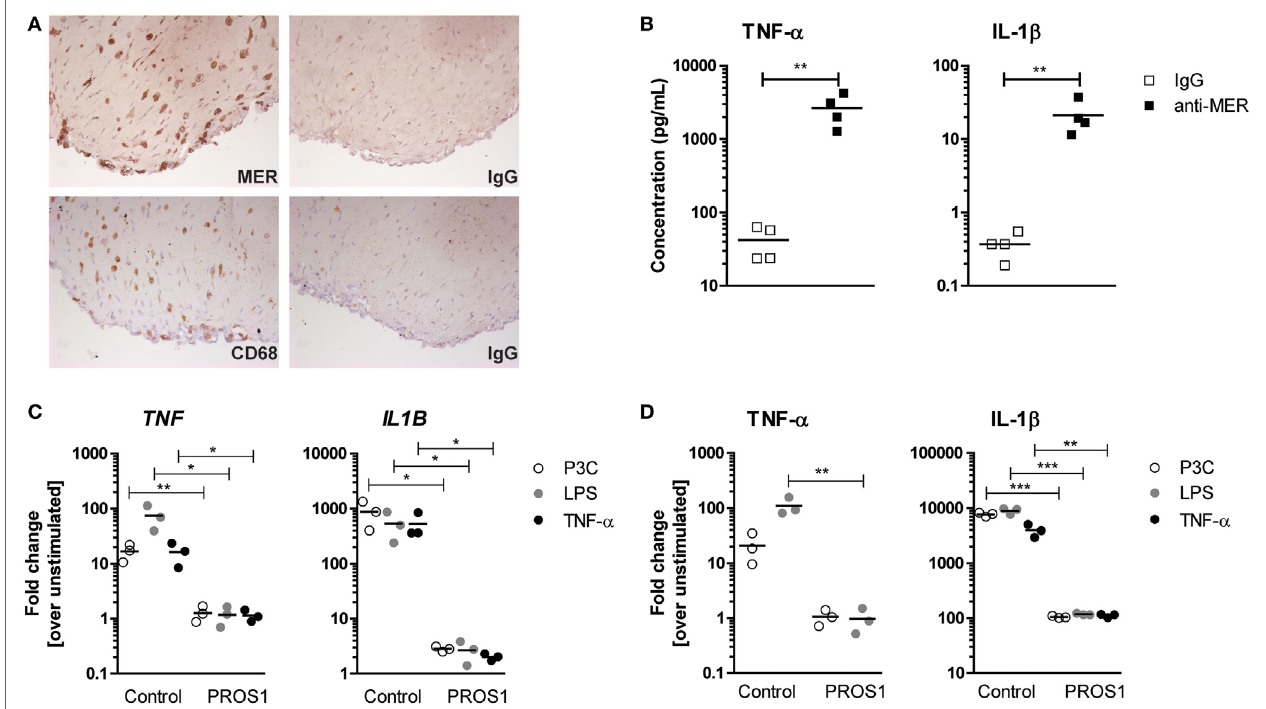
FigUre 3 | Production of pro-inflammatory cytokines by three-dimensional synovial micromasses after anti-MER or PROS1 treatment. (a) Micromasses were examined for their protein expression of MER and CD68 (macrophage marker). Shown are representative pictures and IgG controls. (b) Micromasses were treated with IgG or anti-MER for 24 h. Supernatants were examined for the presence of tumor necrosis factor alpha (TNF- α ) and IL-1 β ( n = 4). (c) Micromasses were preincubated with 50 nM Pros1 for 24 h and stimulated with lipopolysaccharide (LPS) (100 ng/mL), P3C (100 ng/mL), or TNF- α (10 ng/mL) for 6 h. Messenger RNA was extracted and gene expression was determined ( n = 3). (D) Micromasses were pre-incubated with 50 nM Pros1 for 24 h and stimulated with LPS (100 ng/mL), P3C (100 ng/mL), or TNF- α (10 ng/mL) for 24 h. Supernatants were analyzed ( n = 3). All data are representative for two independent experiments. For (b–D) , data are presented as dot-plots with mean. * p < 0.05, ** p < 0.01, *** p < 0.001 with unpaired t -test. See also Figure S3 in Supplementary